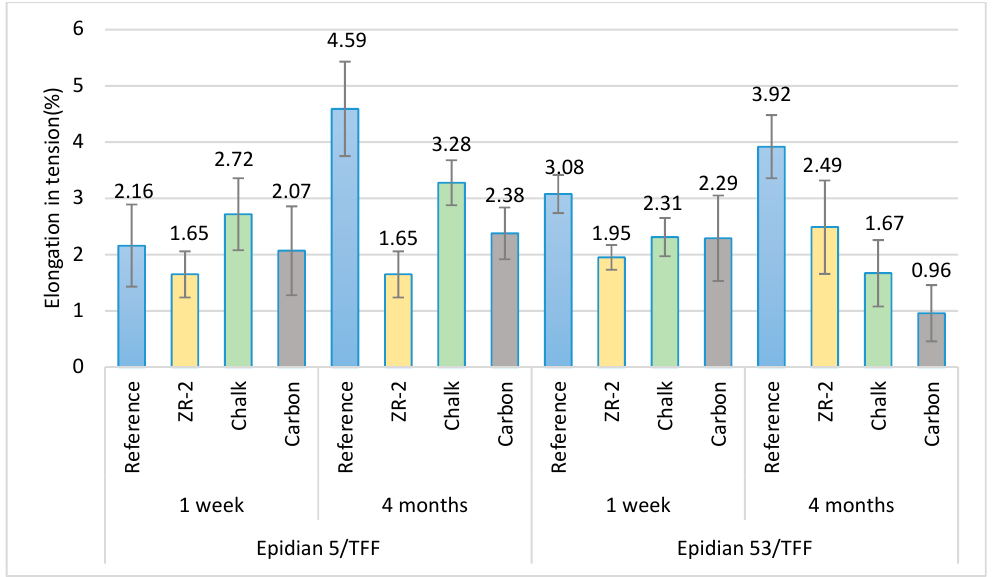
Figure 12. Results of the elongation in tension of the cured adhesive compositions subjected to tests.